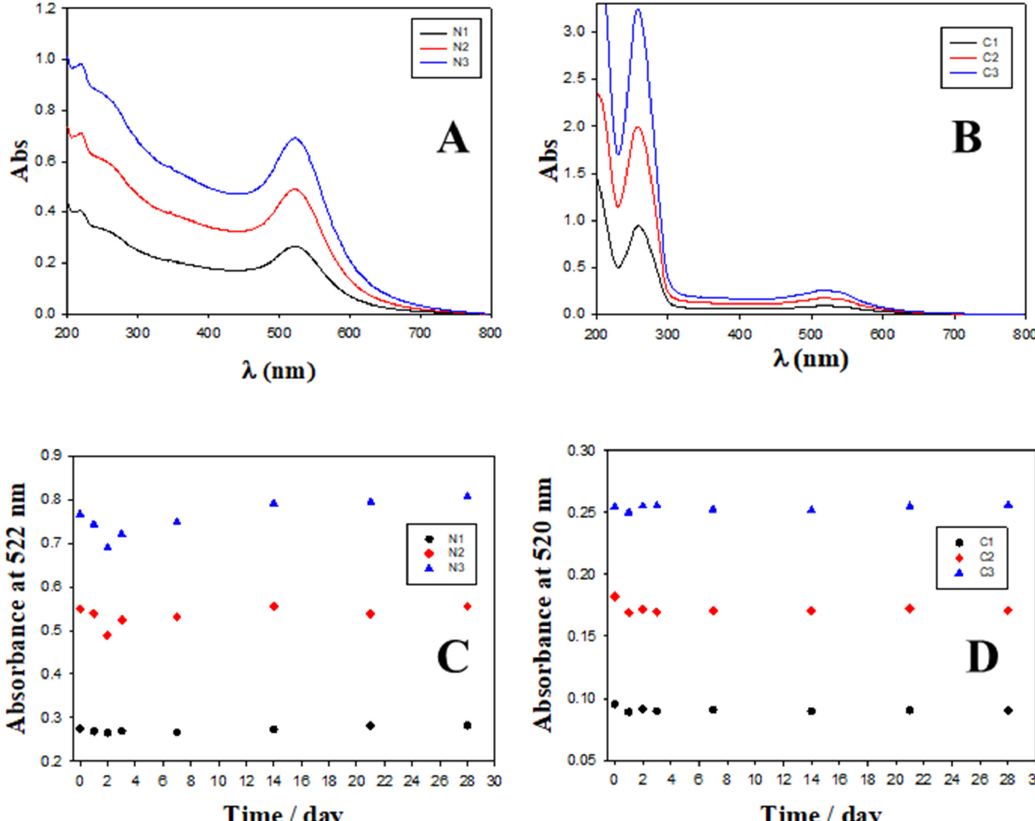
Figure 5. Absorbance spectra and evolution over time of different nanosystems. ( A ) Absorbance spectra of N 1 , N 2 and N 3 Au@16-Ph-16 precursors. ( B ) Absorbance spectra of C 1 , C 2 and C 3 compacted nanocomplexes. ( C ) Evolution over time of absorbance at fixed 522 nm wavelength (SPR location) for Au@16-Ph-16 precursors at different concentrations; black circles correspond to [Au@16-Ph-16] = N 1 , red diamonds correspond to [Au@16-Ph-16] = N 2 and blue triangles to N 3 . ( D ) Evolution over time of absorbance at a fixed 520 nm wavelength for compacted nanocomplexes at different concentrations; black circles correspond to [Au@16-Ph-16/DNA–Doxo] = C 1 , red diamonds correspond to [Au@16-Ph-16/DNA–Doxo] = C 2 and blue triangles to C 3 . On the other hand, the controlled drug release constitutes a key parameter to be improved to ensure the correct clinical translation of new nanomedicine [74]. In this study, the percentage of drug release was evaluated by using the fluorescence spectroscopy technique and the appropriate calibration curve (see Section 3.2.3 for more details and Figures S11,S12). From such experiments, a %DR of 92.6% and a half life time (t 1/2 ) of 11.4 min were obtained. These results clearly show that a high percentage of Doxo was released from the C 3 -compacted nanocomplex after the addition of N 3 in only 60 min of stabilization (see Figure S12). Therefore, it was demonstrated that the controlled in vitro release of Doxo from the nanocomplex is possible by tuning the DNA conformation from compacted to decompacted forms using the appropriate C Au@16-pH-16 concentration, indicating the goodness of the developed nanomedicine.